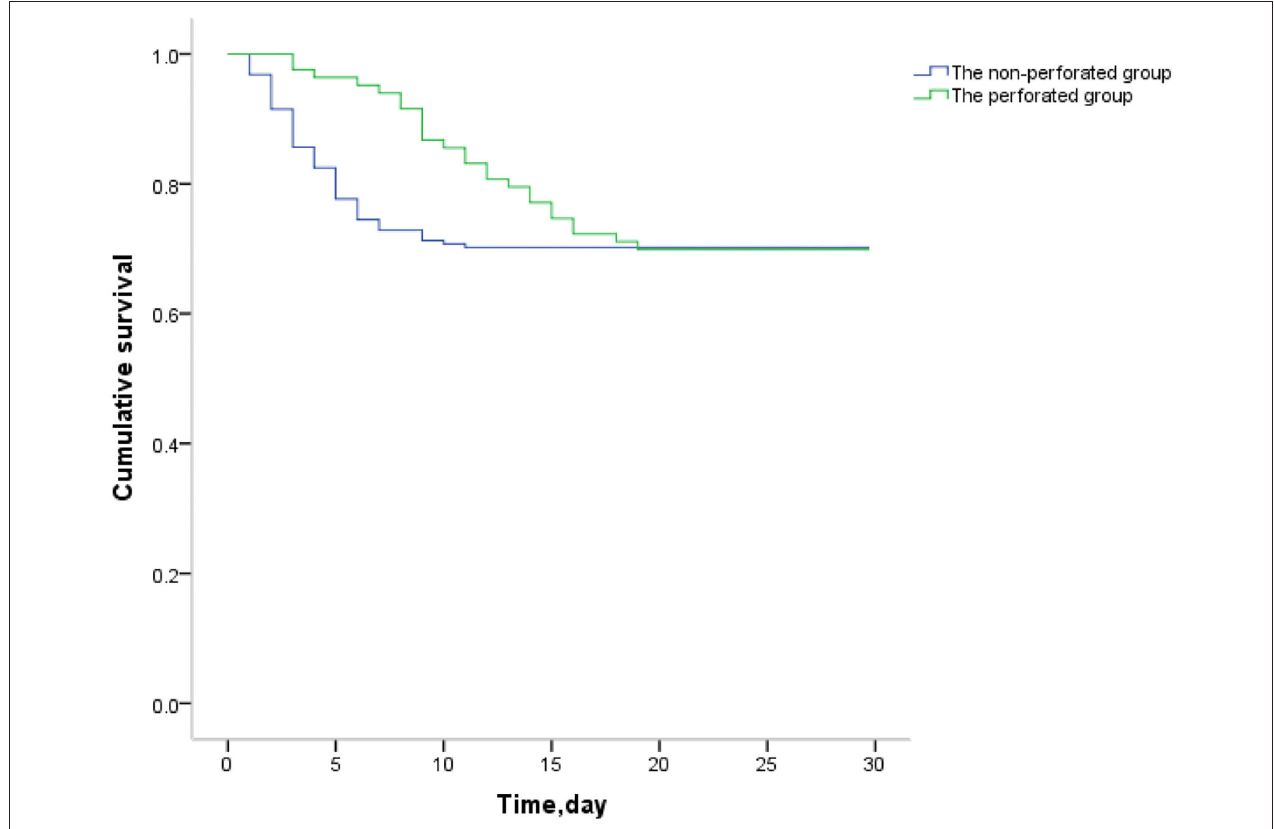
FIGURE 1 | Survival at 30 days outcome of the non-perforated vs. the perforated groups. The mortality occurred earlier in the non-perforated group than the perforated